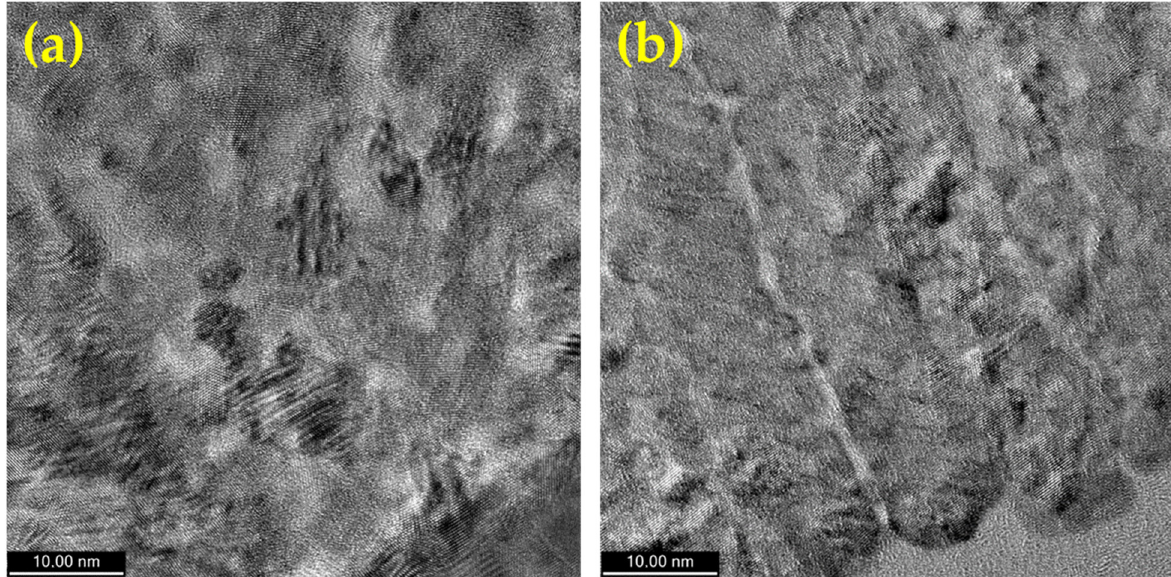
Figure 6. HR-TEM images of the cross-section of the electrodeposited CoPt alloy for various elec- trodeposition solution: ( a ) pH = 5.5 solutions without saccharin addition (sample S3), ( b ) pH = 5.5 solutions with saccharin addition (sample S4).